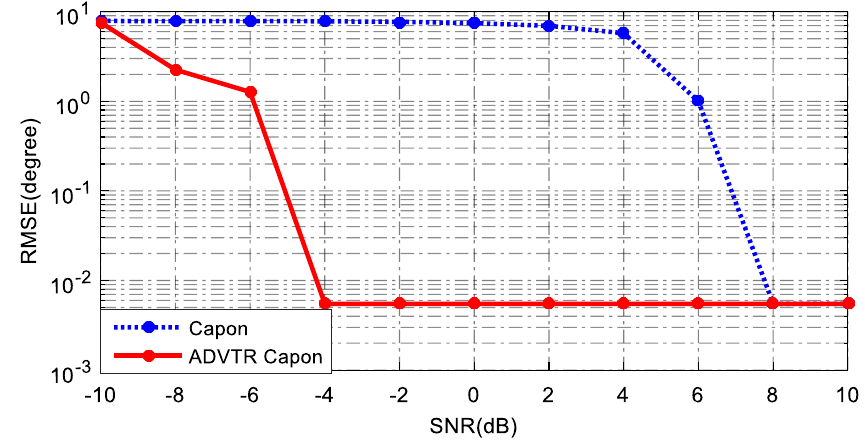
Figure 16. RMSE for Capon estimator and ADVTR Capon estimator in the tank.